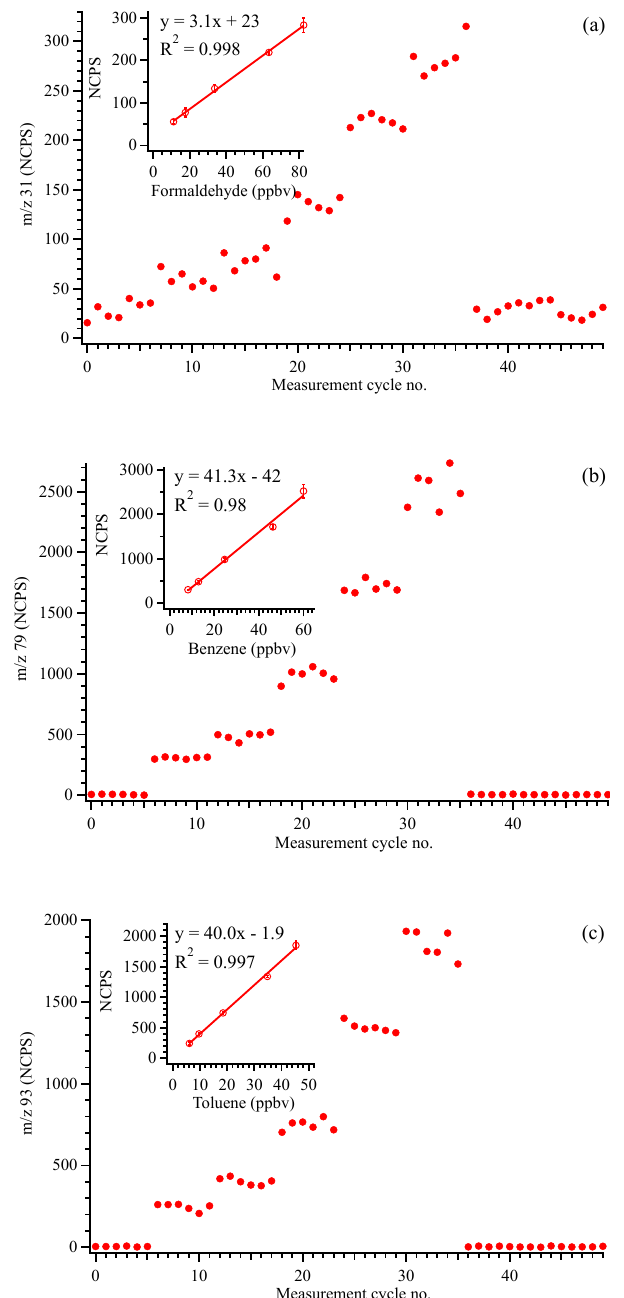
Figure 4. Time series of a typical set of calibration of HCHO (a) , benzene (b) , and toluene (c) . The insert in each panel is the calibra- tion curve obtained from the corresponding calibration data.